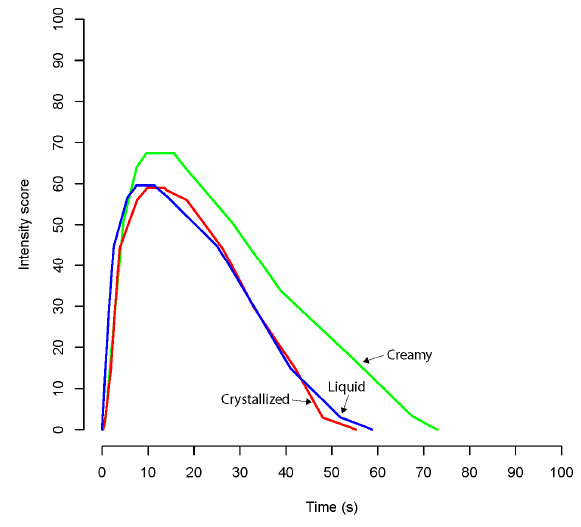
Figure 3. Time intensity curves for citrus honey samples.